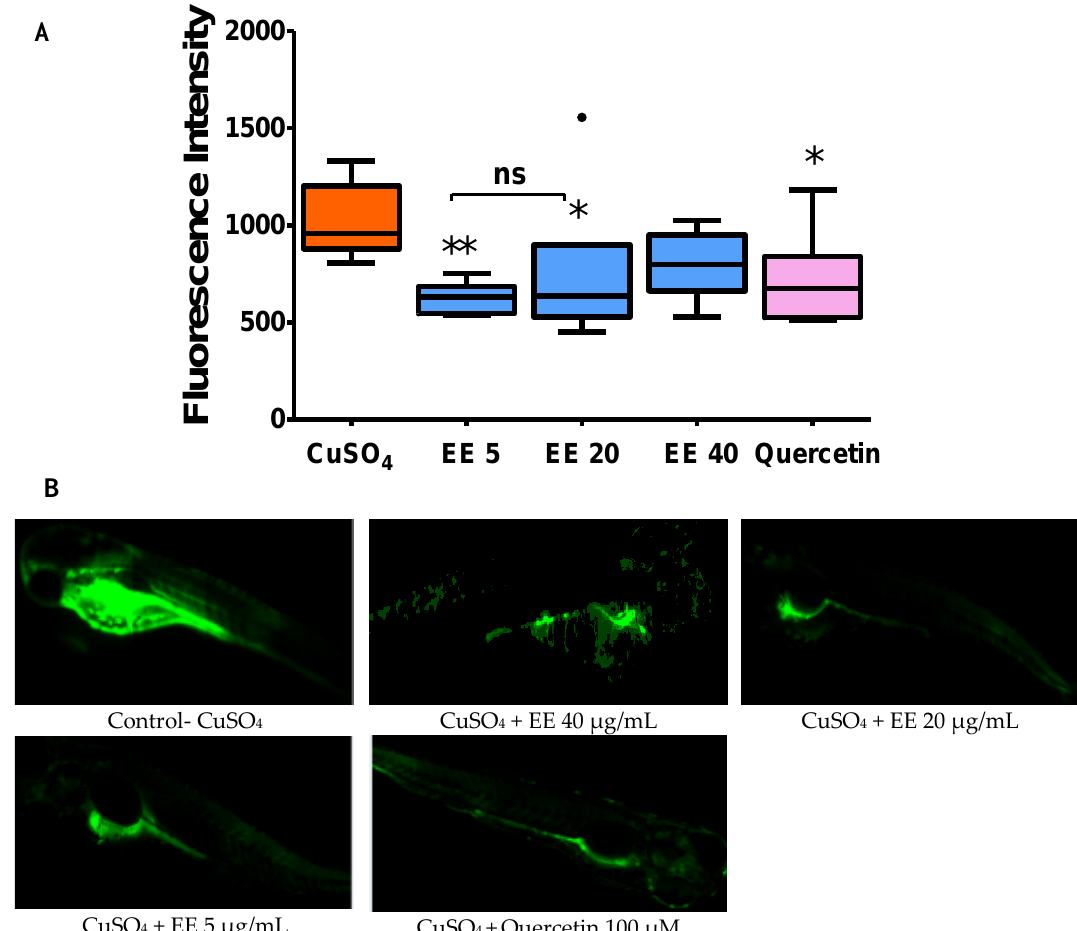
Figure 3. Inhibitory effect of ethanol extract (EE) from leaves of C. cyrtophyllum Turcz on CuSO 4 -stimulated ROS production in zebrafish larvae. The zebrafish were exposed to different concentrations of EE (5, 20, and 40 µg/mL) or 100 µM quercetin for 1 h and then exposed to 10 µM CuSO 4 for 20 min to induce oxidative stress. After 20 min, larvae were incubated with H2DCFDA (20 µg/mL) for 1 h. Fluorescent probes were used to detect and quantify oxidative stress by measuring the fluorescent intensity (FI) in larvae using Autovision software and a BD pathway 855 system (BD Biosciences). ( A ) Fluorescence intensity obtained from individual zebrafish larvae. The data are presented as medians for six different larvae, * p < 0.05 and ** p < 0.01 compared to the CuSO 4 alone Group. ( B ) Representative fluorescence micrographs of ROS production.